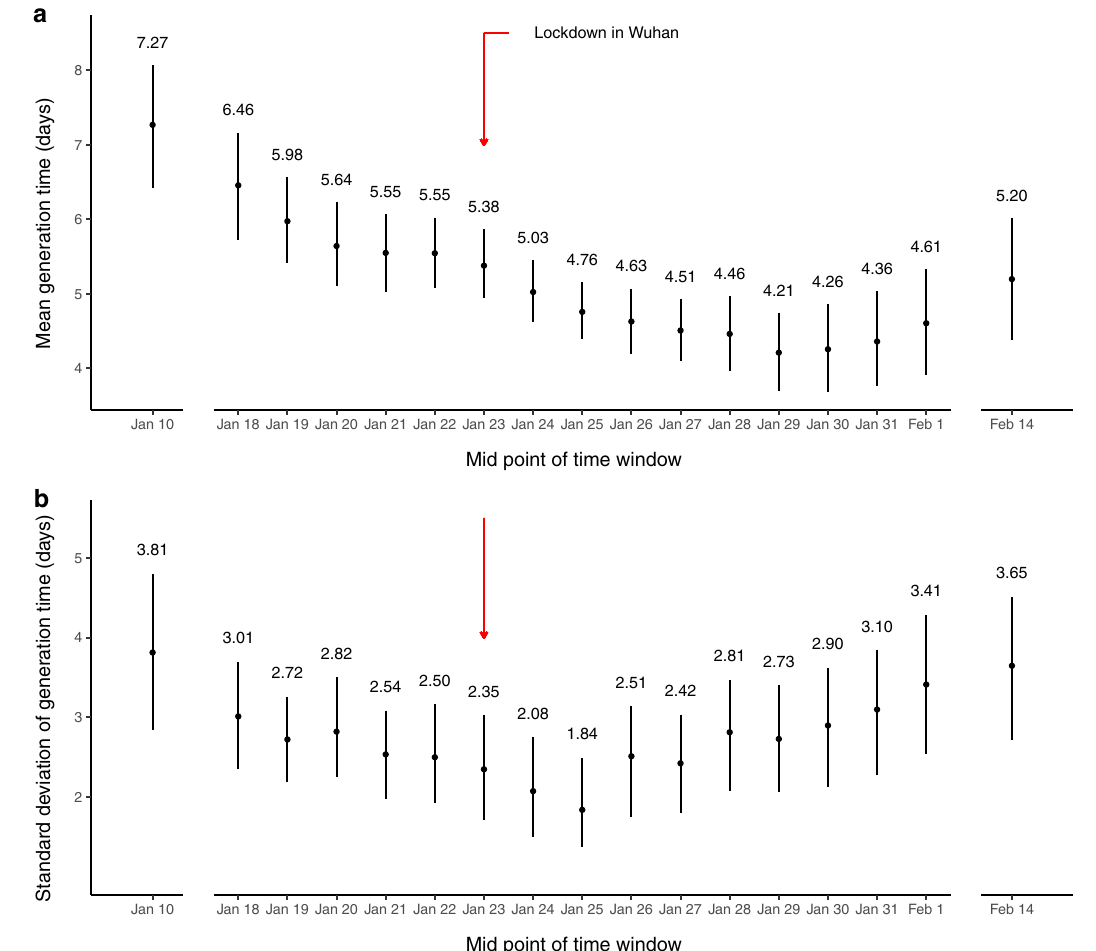
Fig.4|Temporalestimatesofforwardgenerationtime(GT)distributions.a The temporal estimates of mean of forward GT. b The temporal estimates of standard deviation of forward GT. The dots and segments showed the mean estimates and thecorresponding95%con fi denceintervals(CIs),respectively.Redarrowindicates lockdown in Wuhan and the implementation of public health social measures